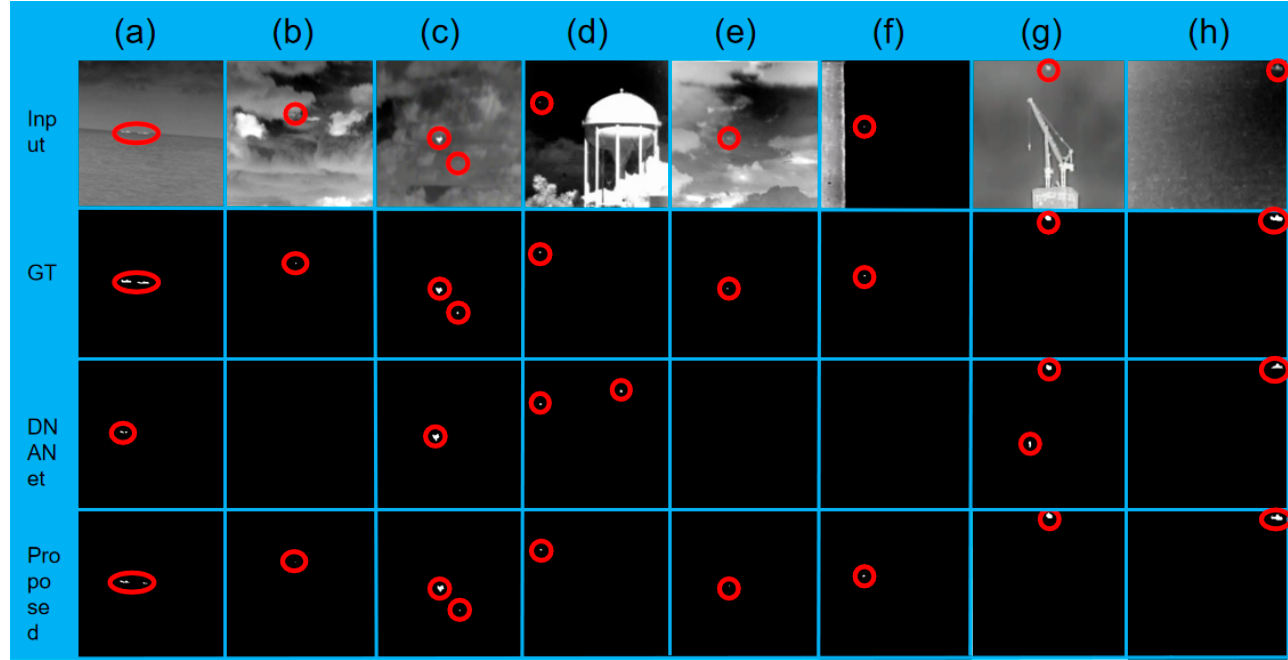
Figure 13. Detection results before and after upsampling.